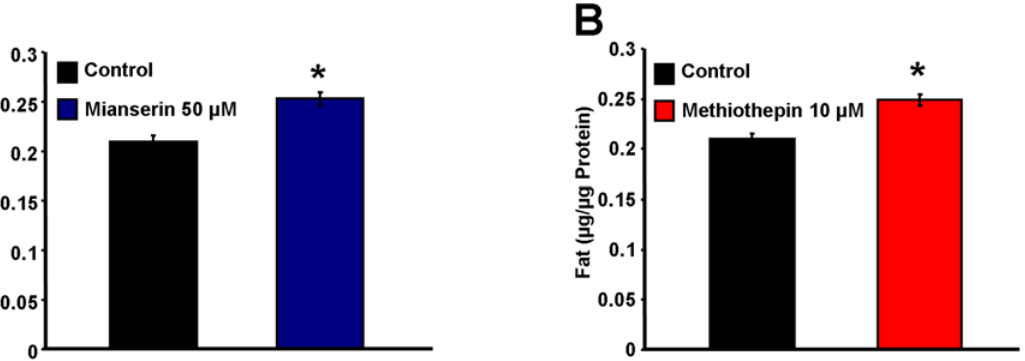
Figure 2. Antidepressants of the human serotonin antagonist type increase Caenorhabditiselegans body fat content. Panel A: The antidepressant mianserin increases C.elegans body fat content at a concentration of 50 m M (dark blue bar, right side; this concentration was shown extend lifespan in the original publication [ref. 24]) after ten days of treatment; untreated control nematodes are depicted as black bar. Panel B: The related compound methiothepin increases C.elegans body fat content at a concentration of 10 m M (red bar, right side; this concentration was shown extend lifespan in the original publication [ref. 24]) after ten days of treatment; untreated control nematodes are depicted as black bar.